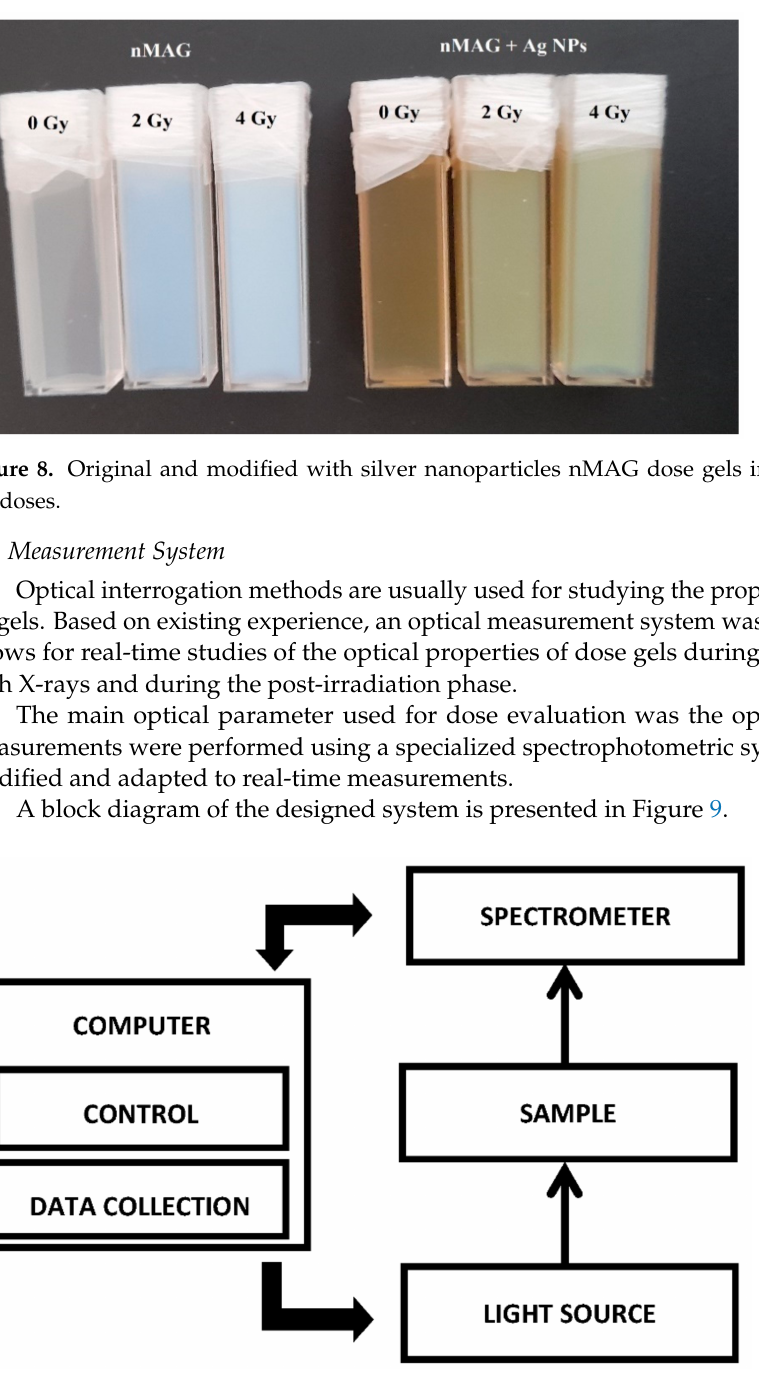
Figure 9. Block diagram of the measurement